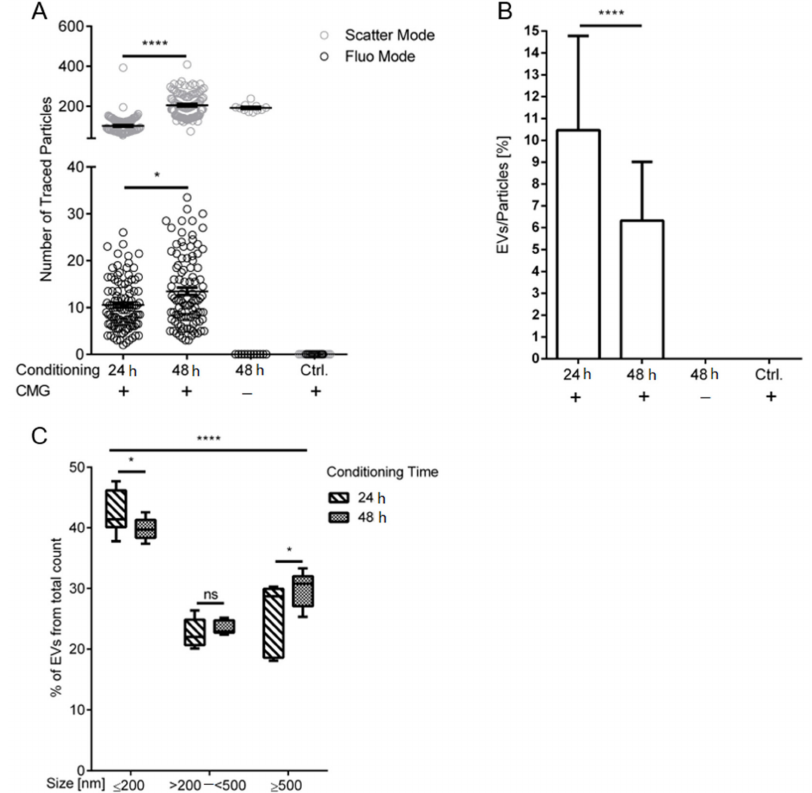
Figure 5. Increasing condition time influences release and size distribution of endothelial derived extracellular vesicles. ( A ) Significant di ff erent numbers of traced particles in the scatter mode from di ff erent conditioning times were detected with a mean of 102 in the “24 h” group and 205 in the “48 h” group. The number of extracellular vesicles (EVs) detected in the fluorescence mode was significantly di ff erent with mean values of 10.6 for the “24 h” group and 13.5 for the “48 h” group. ( B )